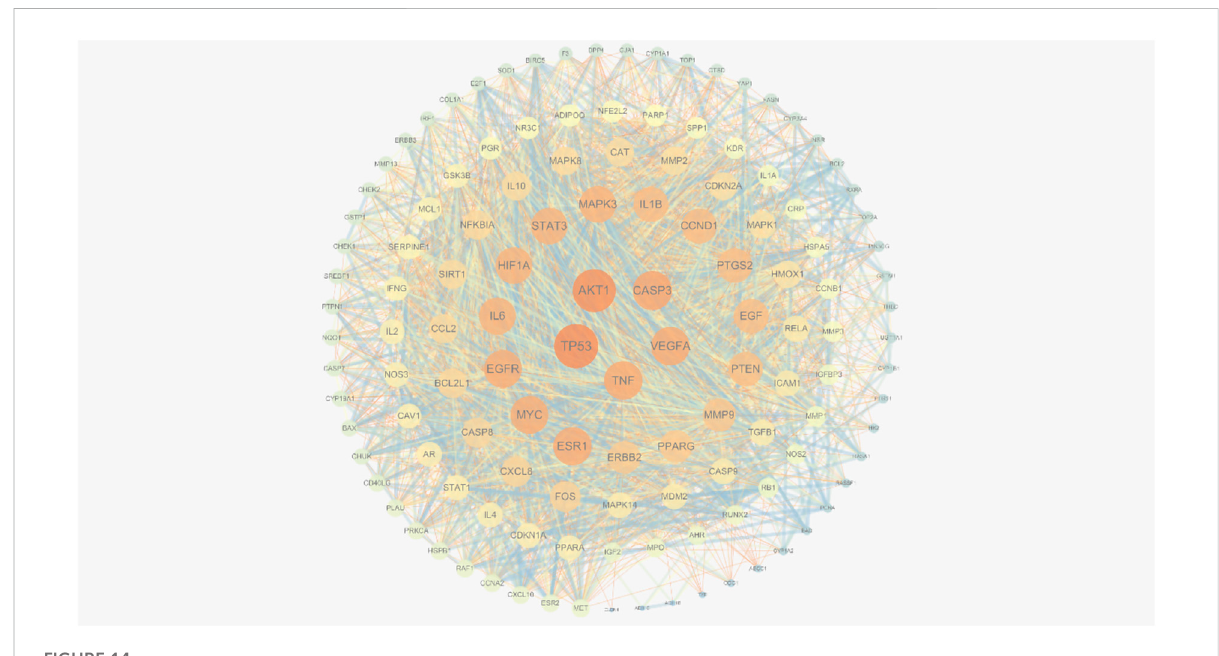
FIGURE 14 PPI network diagram of gastric CRF in botanical drugs treatment.